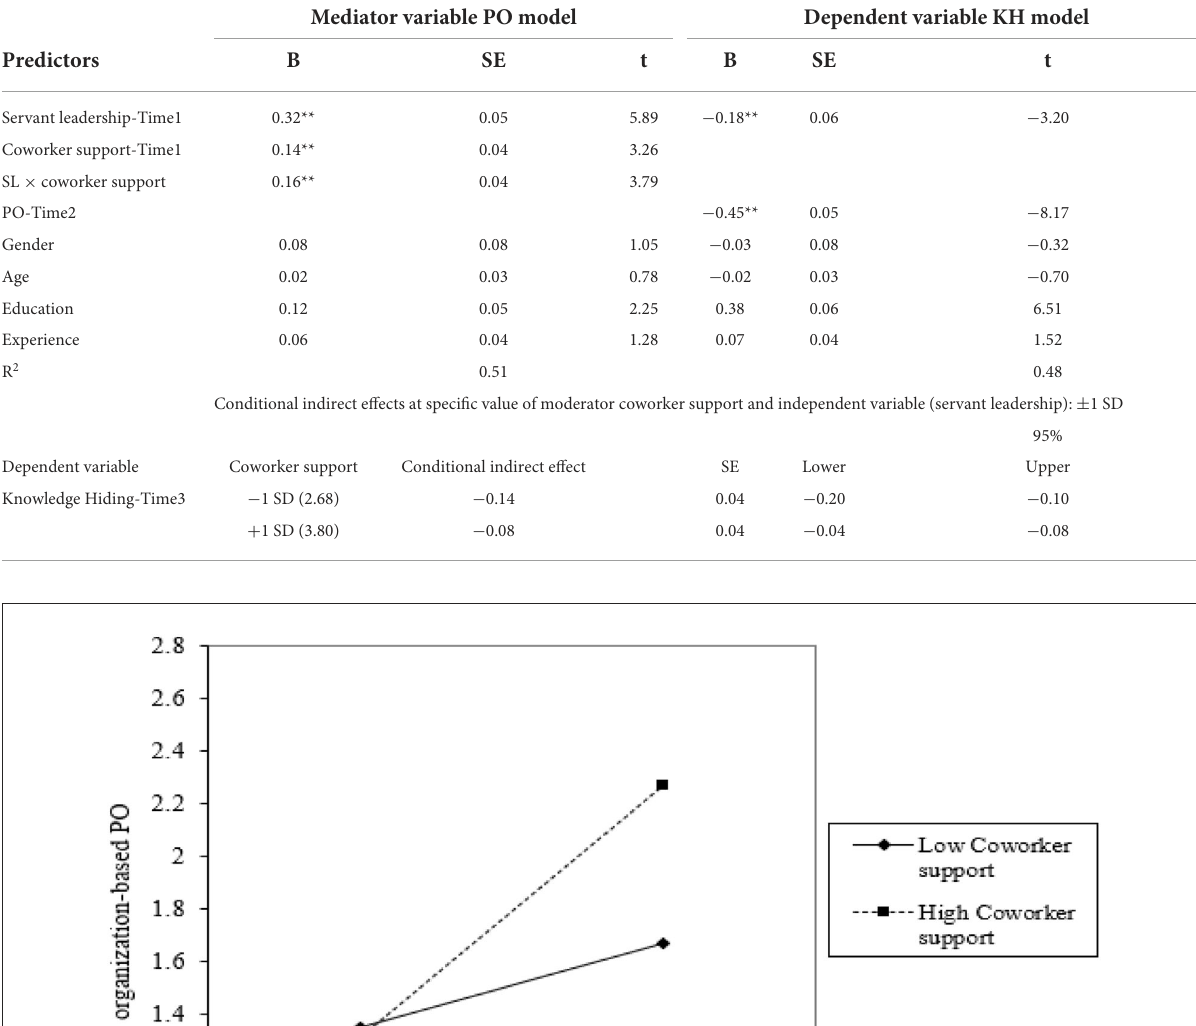
TABLE 3 Moderated mediation analysis for coworker support moderation, po mediation of servant leadership, and knowledge hiding.